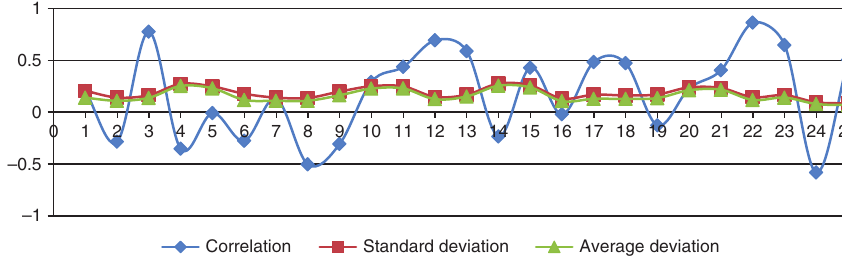
Figure 9: Lee et al. [21] Data Set – Result Analysis for Classes 1–2 Scores.